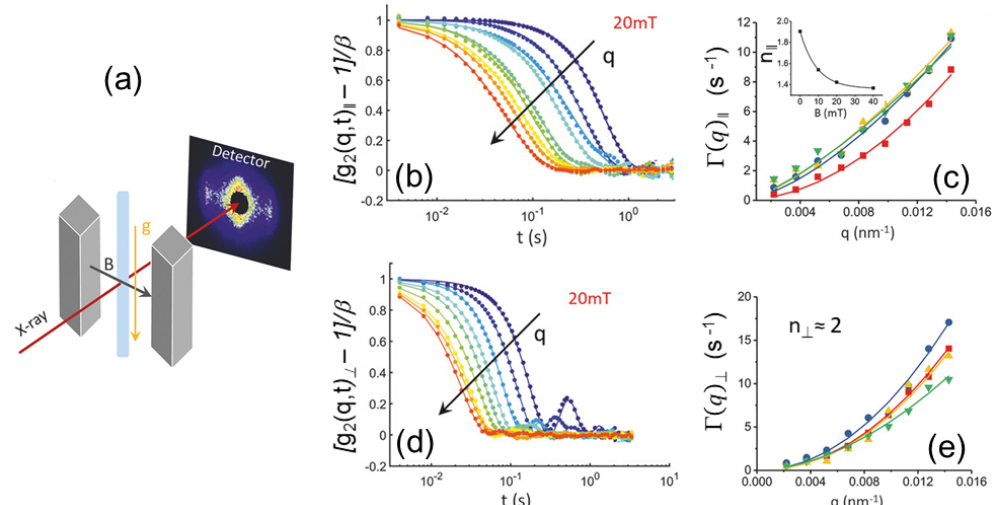
Figure 13. Anomalous dynamics of peanut-shaped anisotropic magnetic colloids (silica-coated hematite in an aqueous solution) in a magnetic field. ( a ) Schematic view of the experiment set-up used for multispeckle XPCS measurements. ( b ) Intensity autocorrelation functions ( β ≡ g 0 : ~0.3) along an horizontal sector parallel to the applied magnetic field (20 mT) and fits to compressed exponential functions (exponent about 1.5). ( c ) Anomalous dynamics showing Γ ( q ) (cid:107) ∝ q n (cid:107) . The inset displays the variation of n (cid:107) with magnetic field (B). ( d ) Corresponding intensity autocorrelation functions along the vertical sector perpendicular to the applied magnetic field. In this case, the dynamics is dominated by velocity fluctuations due to sedimentation [110]. ( e ) The Brownian part of the dynamics follows the expected behavior, Γ ( q ) ⊥ ∝ q n ⊥ , with n ⊥ ∼ 2. Adapted from A. Pal et al. [109] c GmbH & Co. KGaA